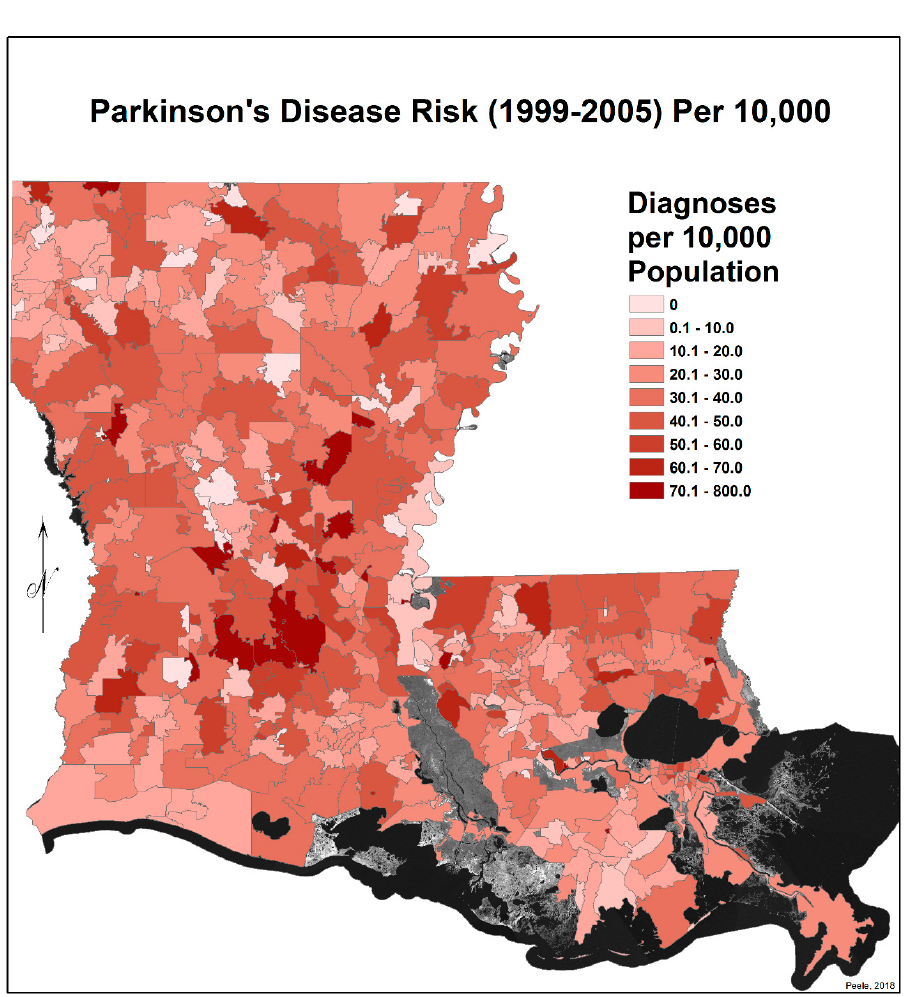
Figure 1. Parkinson’s disease risk for 1999–2005 per 10,000 persons by Louisiana ZIP Code.